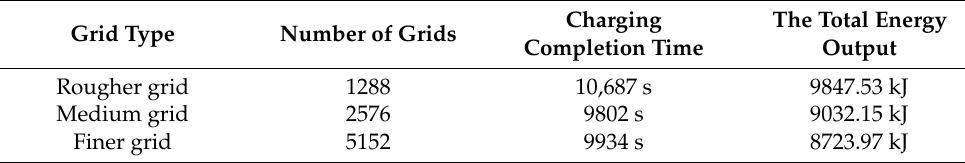
Table 3. Results of the mesh-independence